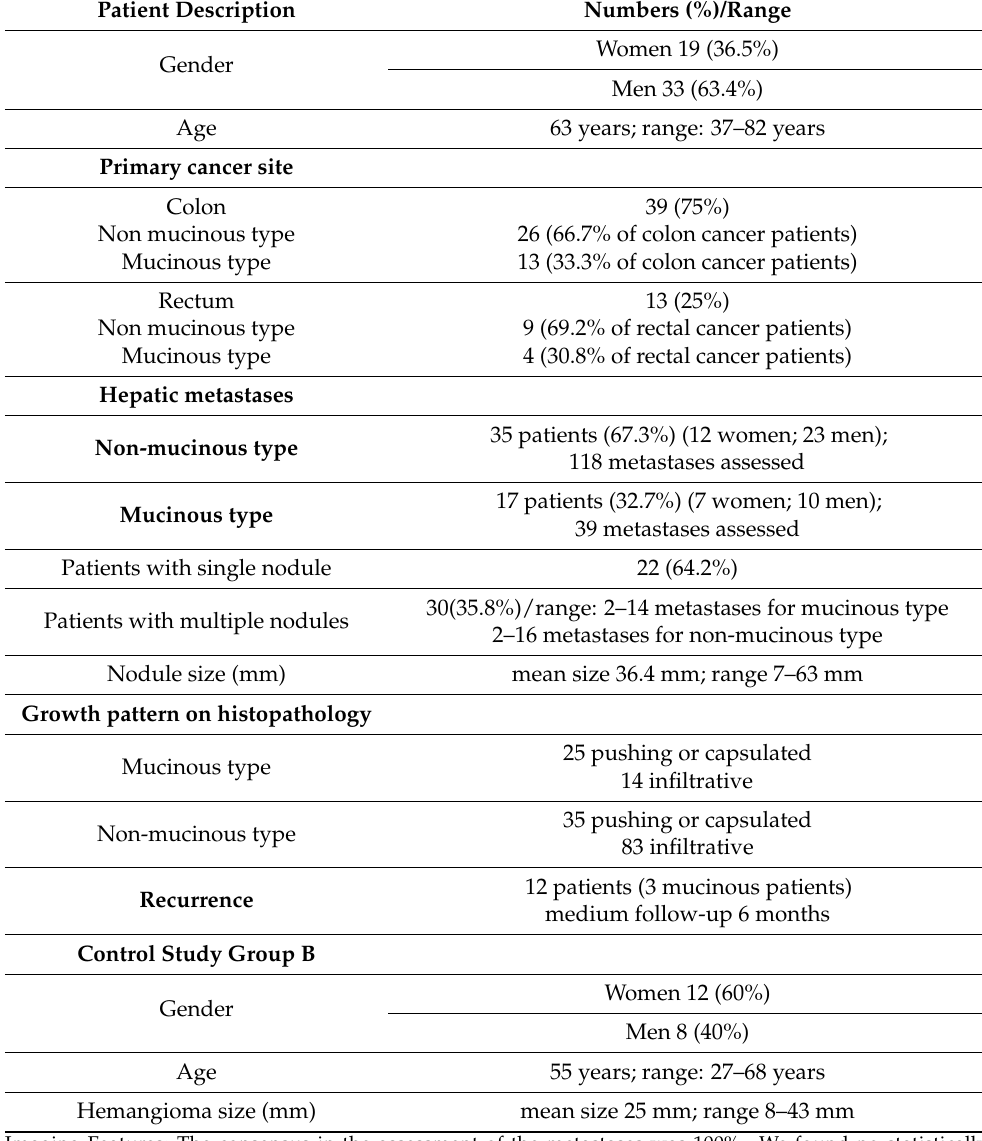
Table 1. Characteristics of the study population (52